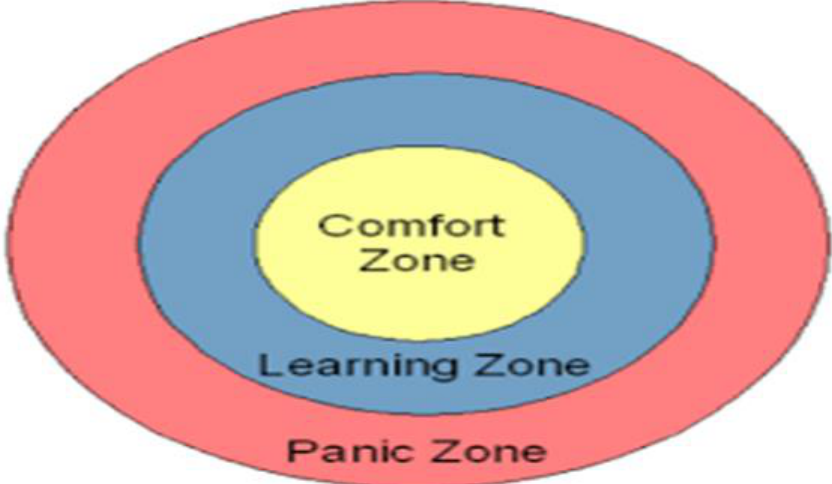
Figure 2. Learning zone model [© ThemPra Social Pedagogy,